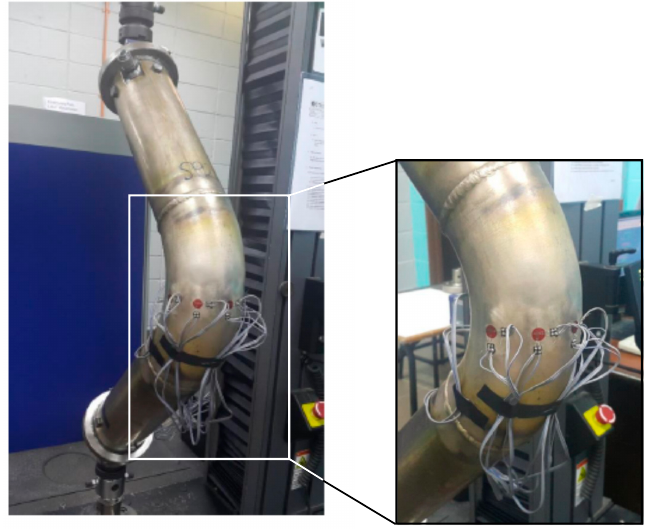
Figure 3. Test specimen equipped with strain gauge rosettes.